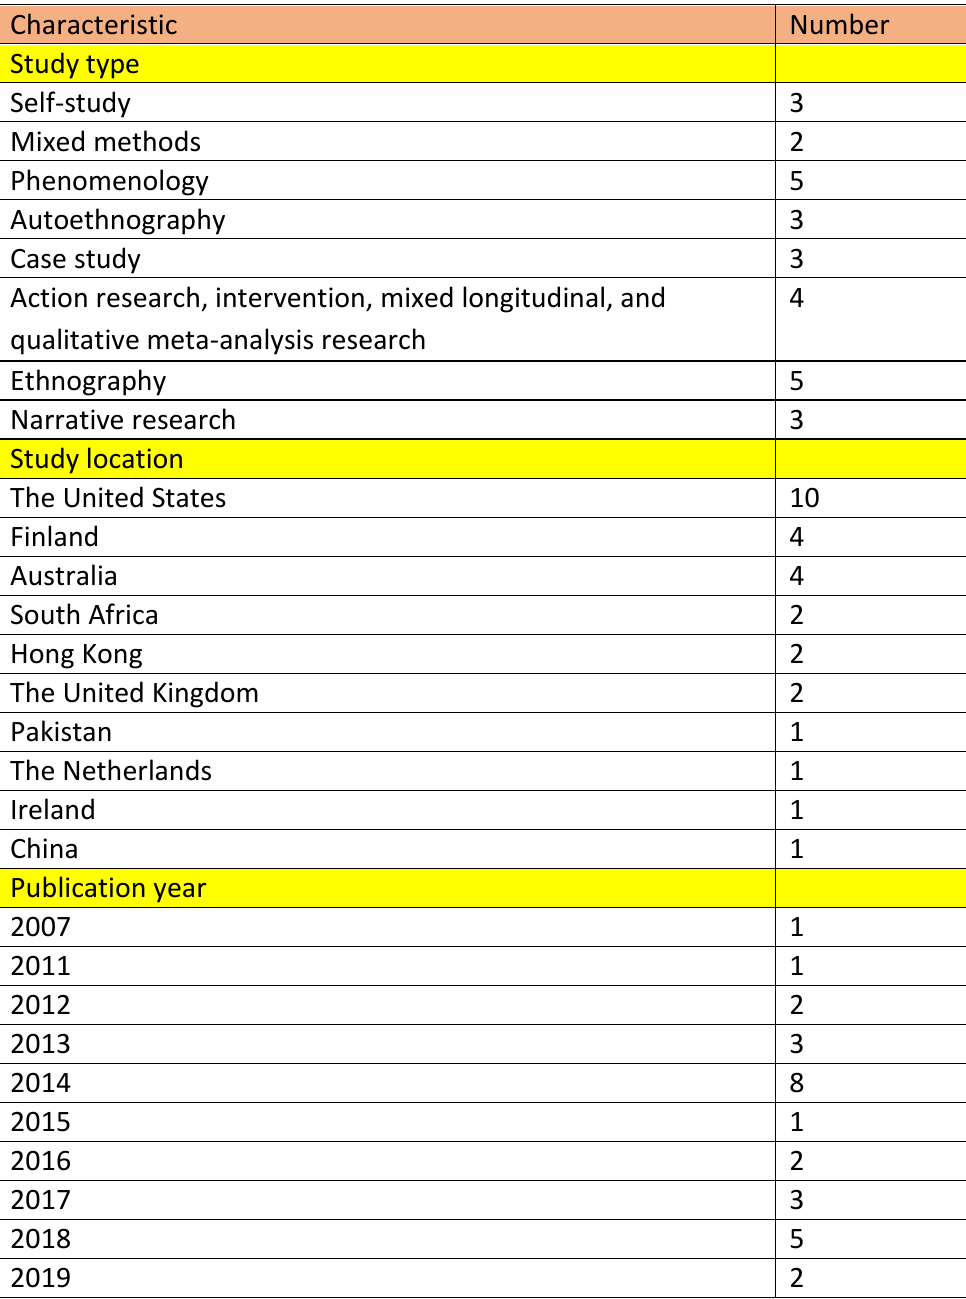
Table 1. Descriptive summary of the included studies